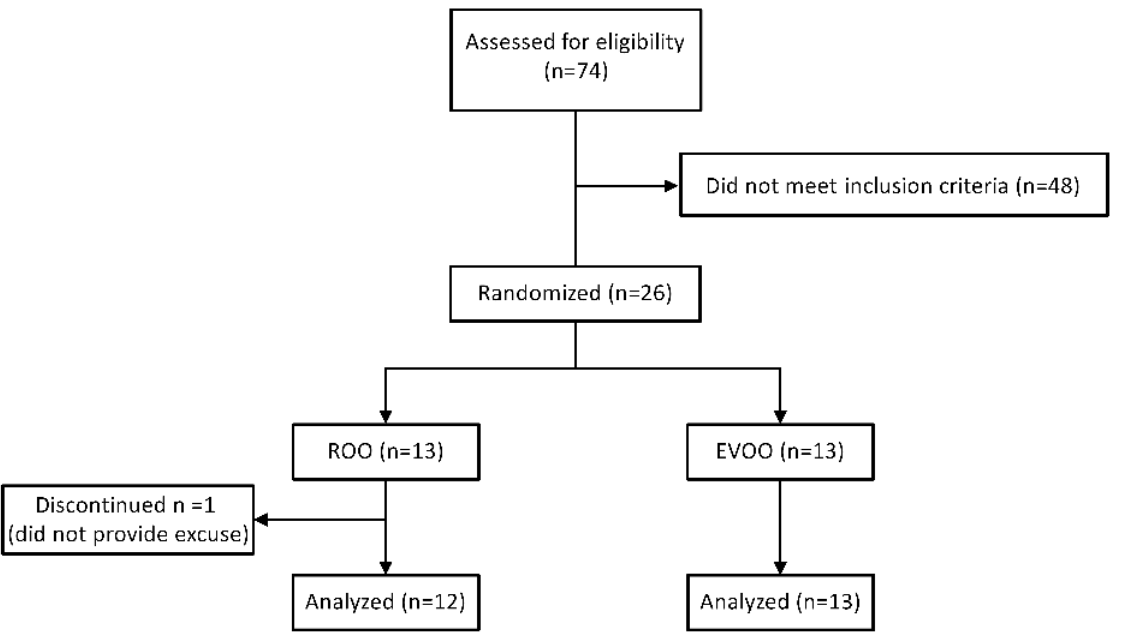
Figure 1. Trial profile.